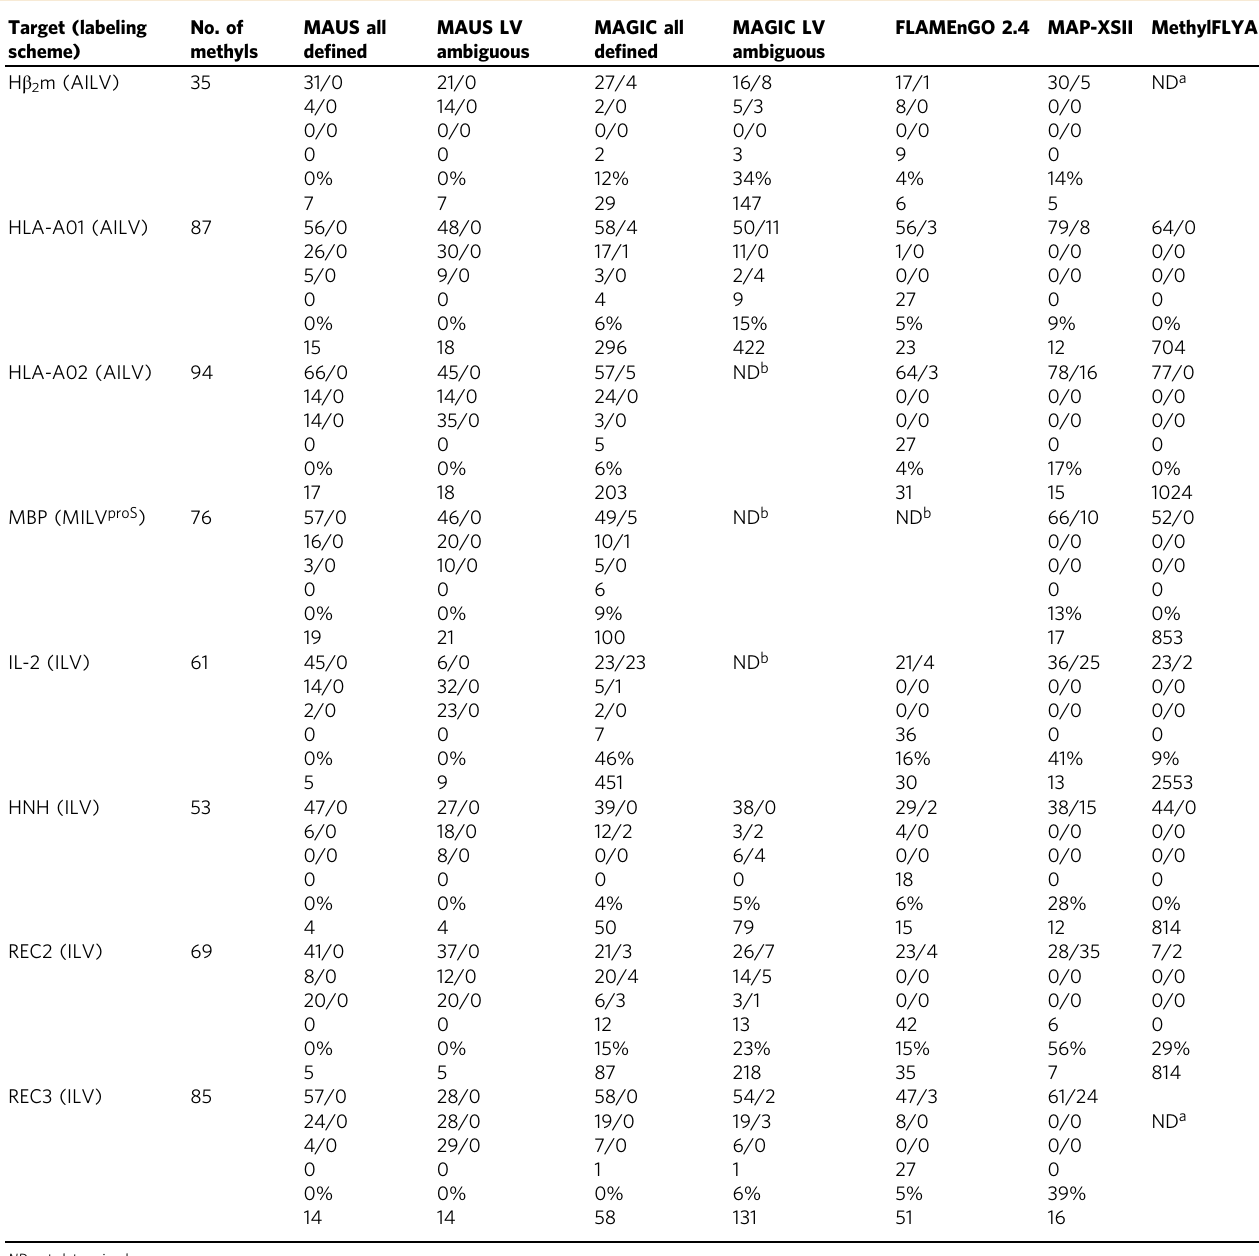
Table 2 Performance comparison of different methyl assignment programs. Target (labeling